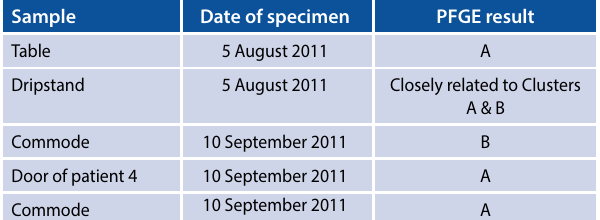
Table 4: Results of PFGE of five environmental samples from HU Sample